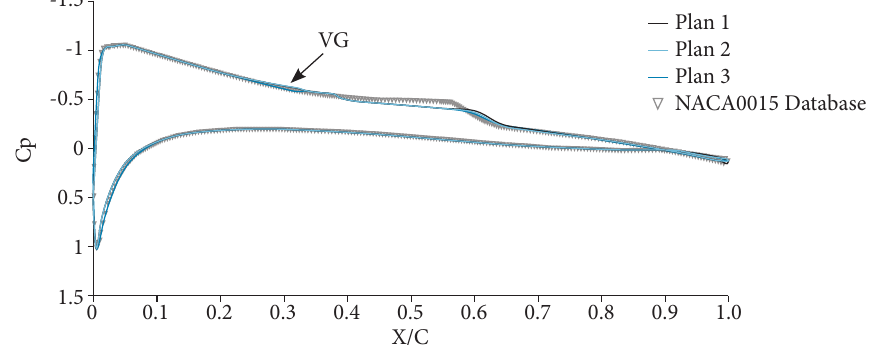
Figure 17. Pressure distribution along Plans 1, 2 and 3 for NACA 0015 airfoil with and without VG in Re c = 2.38 × 10 5 and AoA = 3.